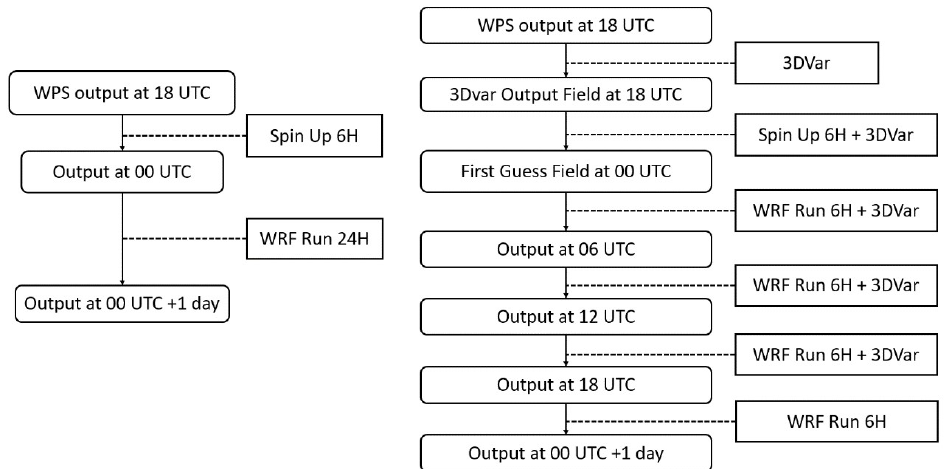
Figure 4. Model running process for Tests 1, 2, and 3. Test 1 (left) started the model at 18:00 UTC every day, with 6 hours spin up and 24 hours model run. Tests 2 and 3 (right) started the model at 18:00 UTC every day and assimilated satellite/conventional data at 18:00 UTC, 00:00 UTC (+1day), 06:00 UTC (+1day), 12:00 UTC (+1day), and 18:00 UTC (+1day).